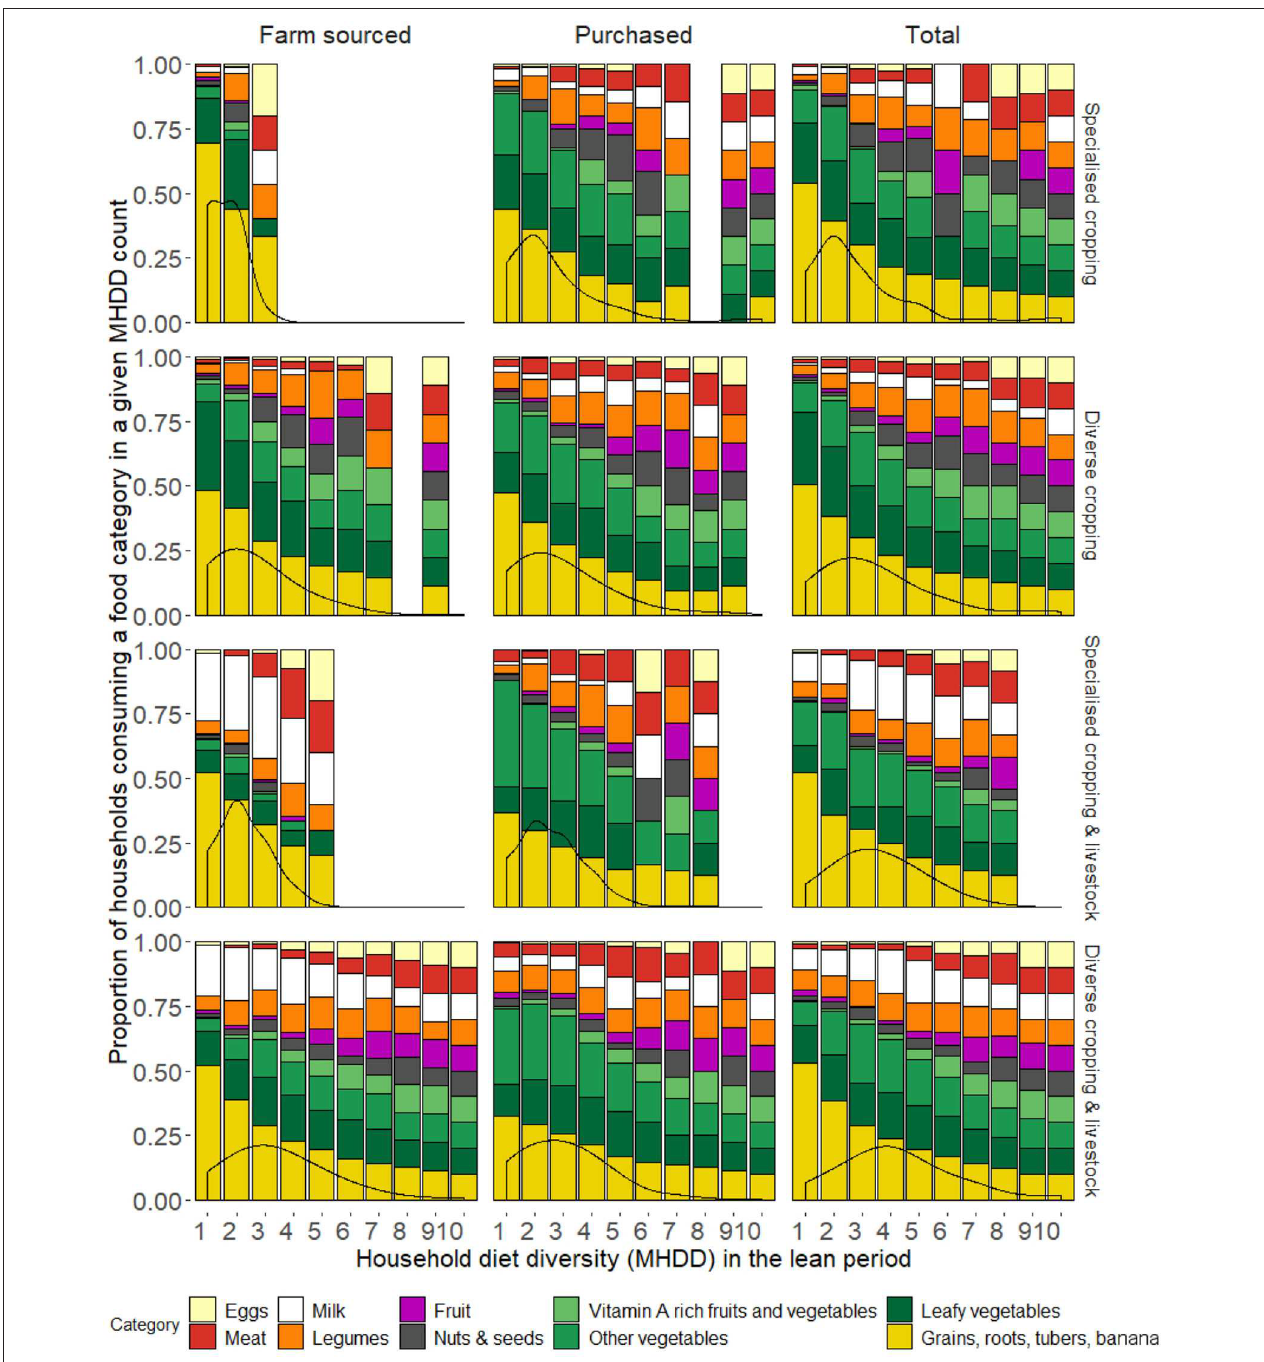
FIGURE 3 | Diet diversity: density and proportion of sampled households ( n = 6,353) consuming specific food categories by farm type, channel of access and total diet diversity in the lean period. The distribution (probability density function) of diet diversity for each period is represented as a black line on the lower half of each figure facet. Food categories are represented by different colors, showing the proportion of households consuming each category at specific diet diversity levels.